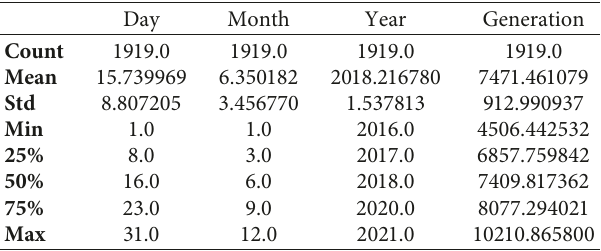
Figure 1: Proposed platform architecture. Table 1: Analysis of energy generation in Mexico from the Eastern region.